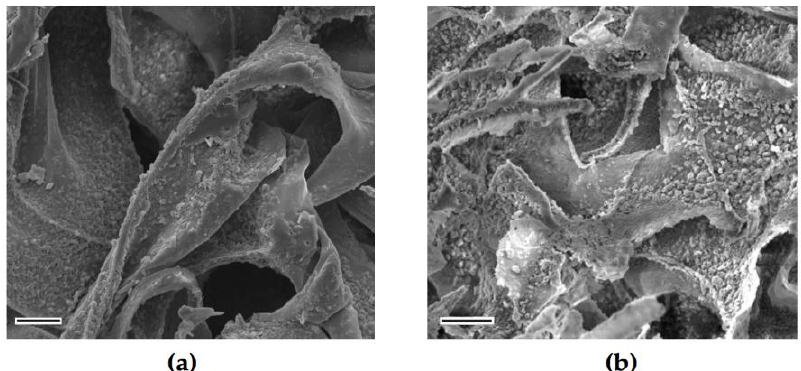
Figure 7. SEM micrographs of lyophilized hydrogels: ( a ) CI:CS; ( b ) CII: CS.0.1HA at 5000 magnification (Scale bars indicate 10 µm).